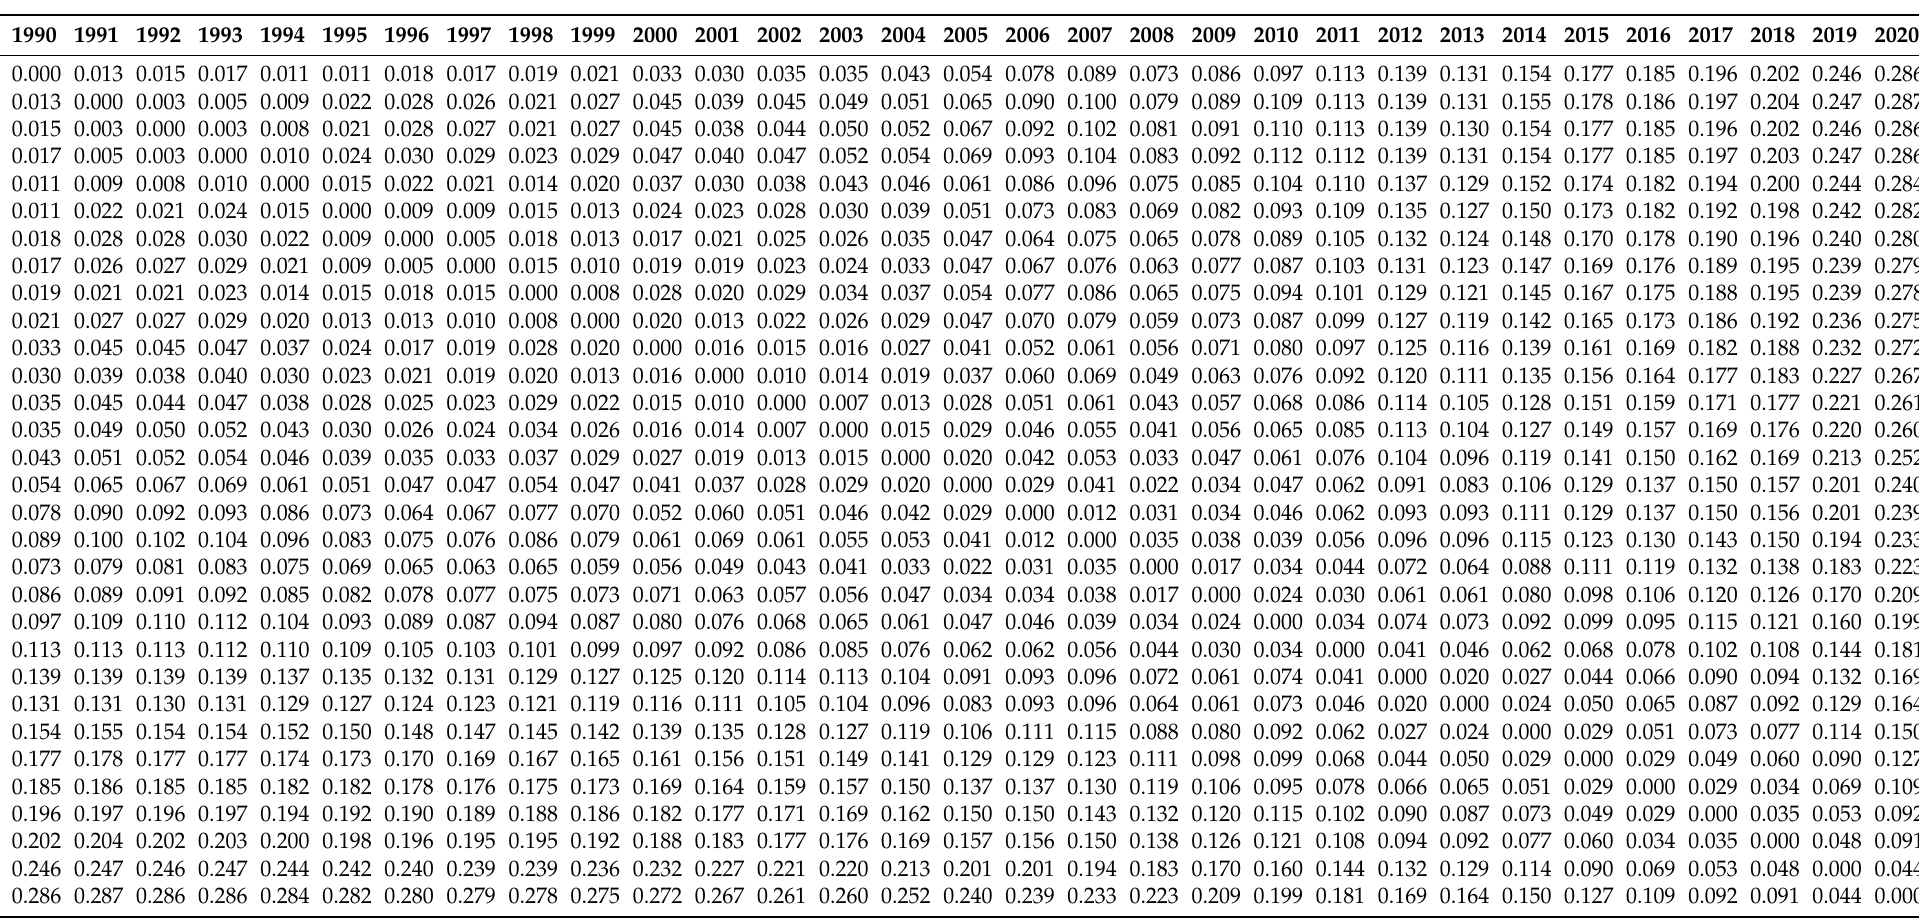
Table A5. Intensity of changes in the structure (NPS) of electricity generation in Poland in